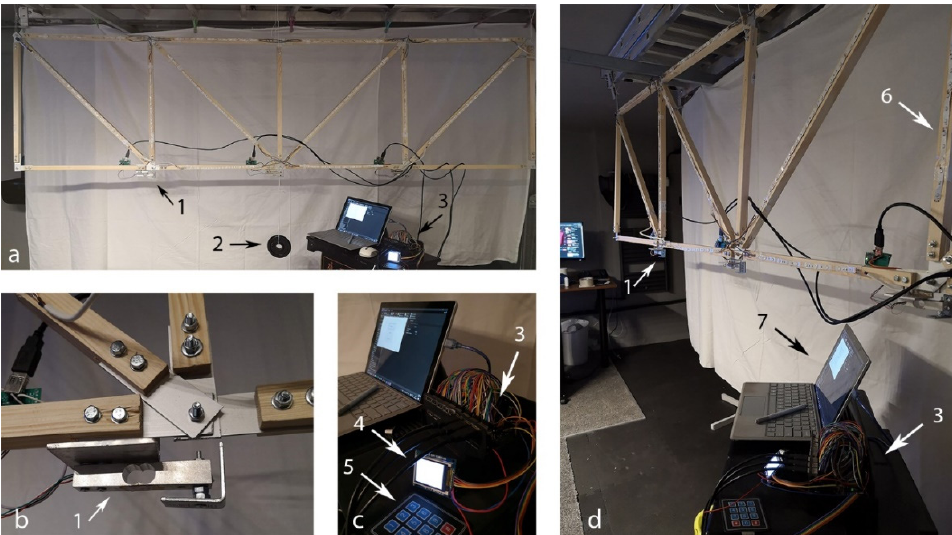
Figure 4. Elements of a truss (1—tensometric beams, gyroscopes, 2—loads, 3—microcontroller, 4—mini display, 5—membrane keyboard, 6—LED strips, 7—PC); ( a ) general view of the truss with a load; ( b ) view of the node with a tensometric beam; ( c ) view of the microcontroller, minidisplay and membrane keyboard; ( d ) view of the truss without a load.